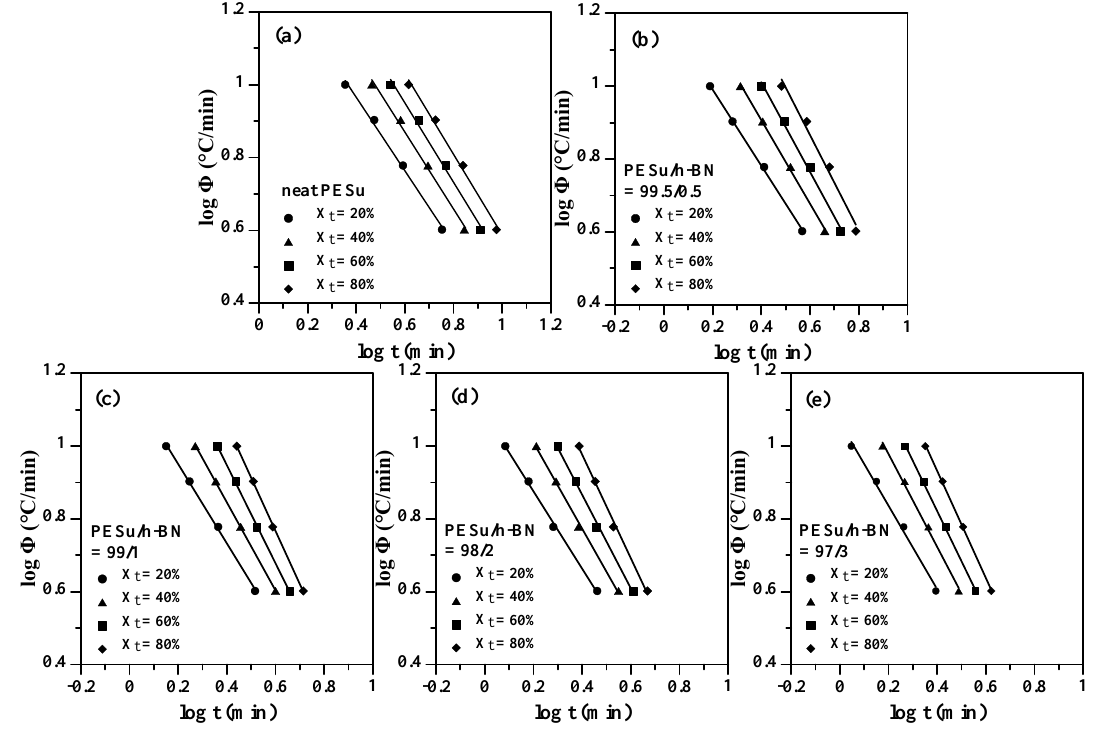
Figure 8. The fitting results of the Mo model on the non-isothermal crystallization behavior of various PESu/h-BN composites. The PESu/h-BN compositions (wt.%) are: ( a ) 100/0; ( b ) 99.5/0.5; ( c ) 99/1; ( d ) 98/2; and ( e ) 97/3.